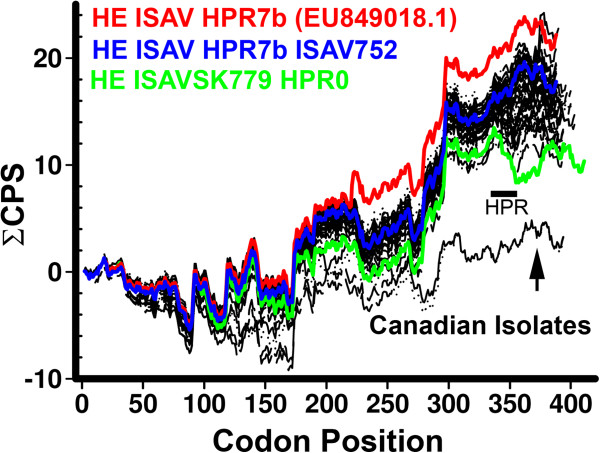
Profile of CPS throughout the HE gene. The figure shows the profile of accumulated CPS values for the 63 HE genes. We highlight the Chilean isolates with HPR 7b, the Canadian isolates and the HPR0 region.